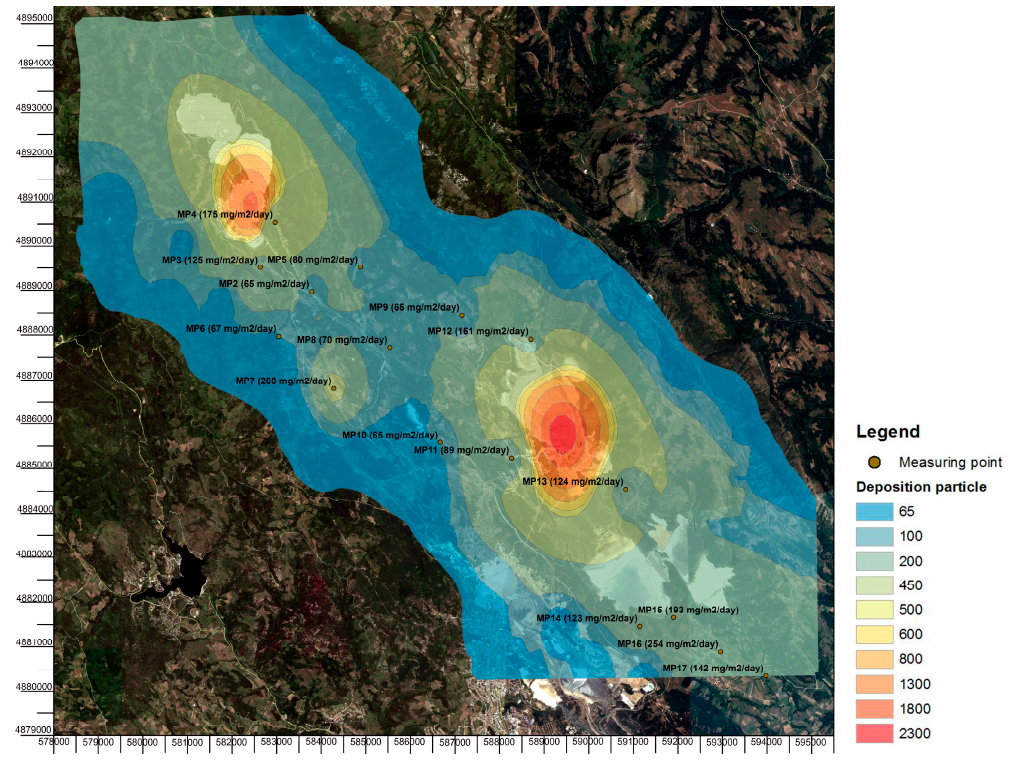
Figure 4. Measurement results of particle deposition levels in vicinity of Bor copper mines in 2016.